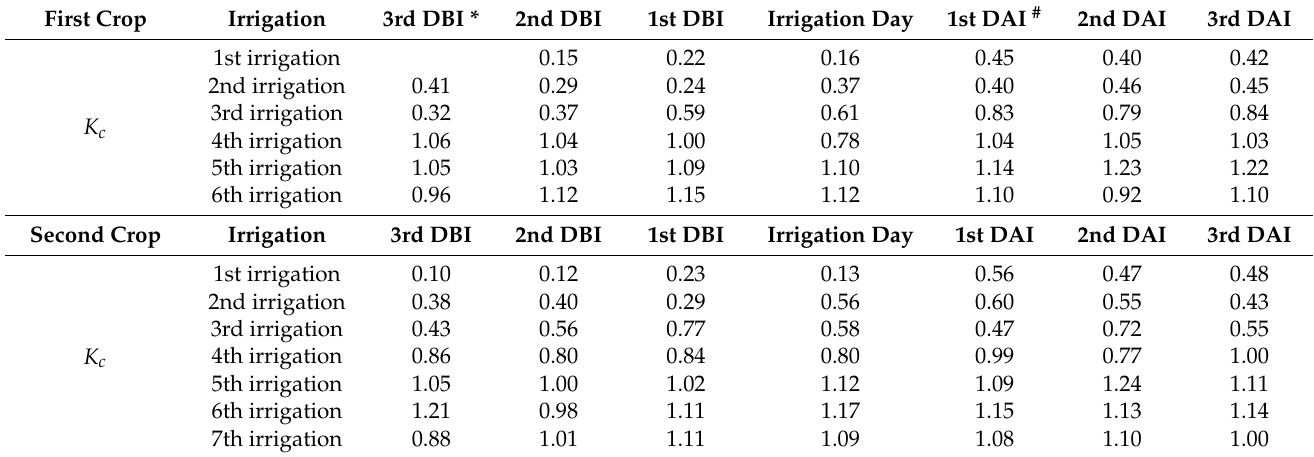
Table 4. Irrigation effect on K c